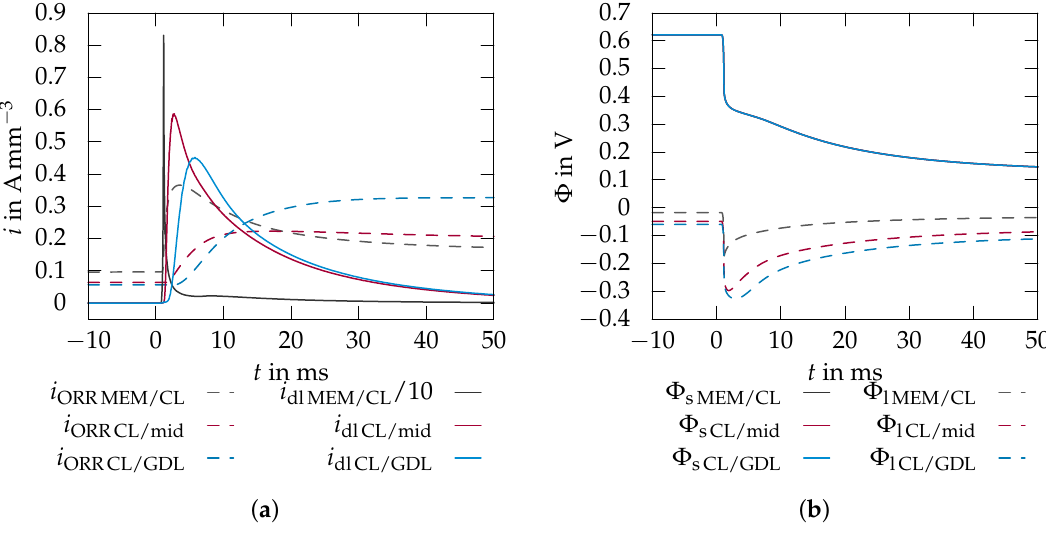
Figure 15. ( a ) Average DL current generation ( i dl , solid) and reaction current generation ( i ORR , dashed) at three positions in the CL for a stationary load of 0.1 Ω prior to the SC. i dl,CL/MEM is plotted on the secondary y-axis, as the peak is more than one order of magnitude above the other contributions. ( b ) Average electric ( Φ s , solid) and electrolyte potential ( Φ l , dashed) at three positions in the CL from the simulation with 0.1 Ω stationary load prior to the SC at different